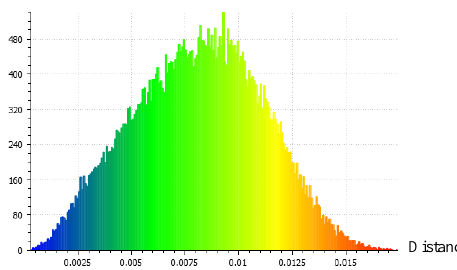
Figure 14. Point-to-Point distance histogram after pyramid registration.